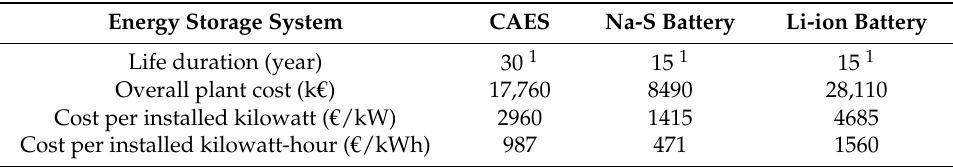
Table 5. Cost comparison among energy storage